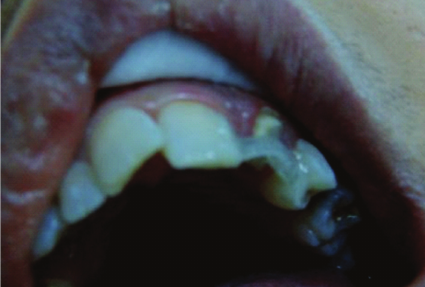
Figure 4: Appearance of the FRC framework with a layer of flow composite between FRC and tooth. Note labial positioning of the framework on the root canal post of canine.